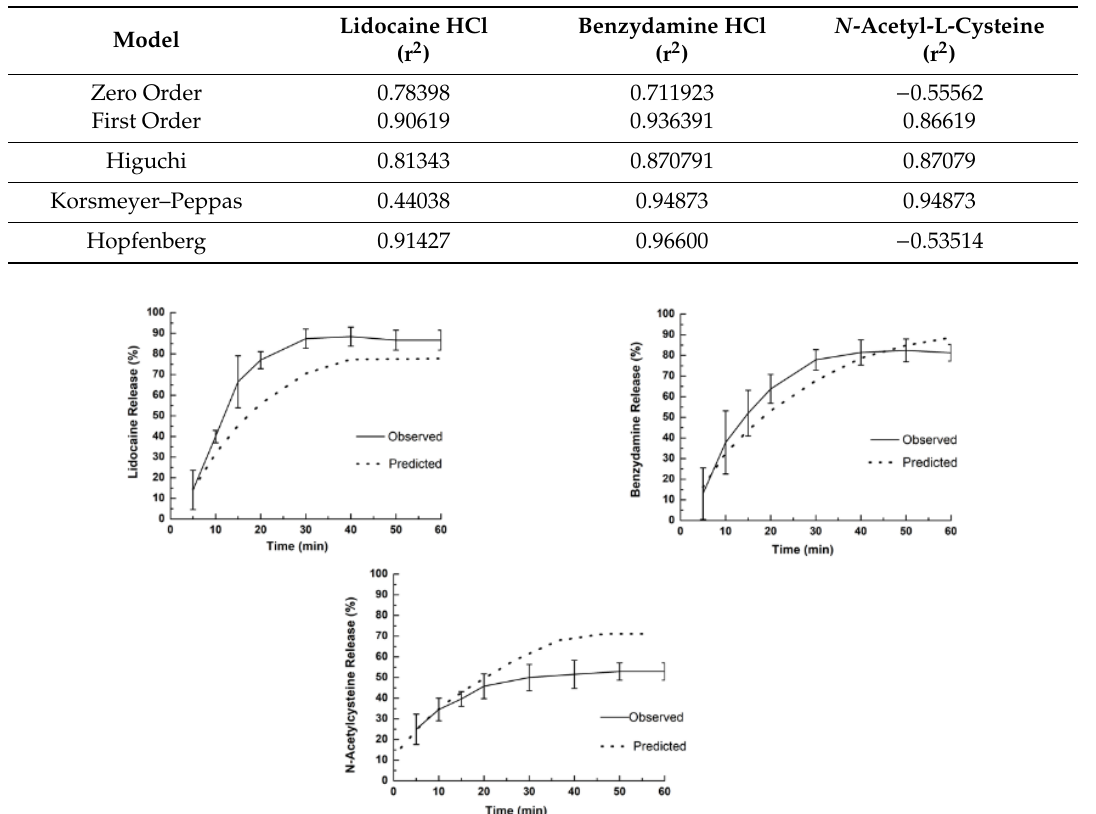
Table 6. Kinetics release of lidocaine HCl, benzydamine HCl, and N -acetyl-L-cysteine.